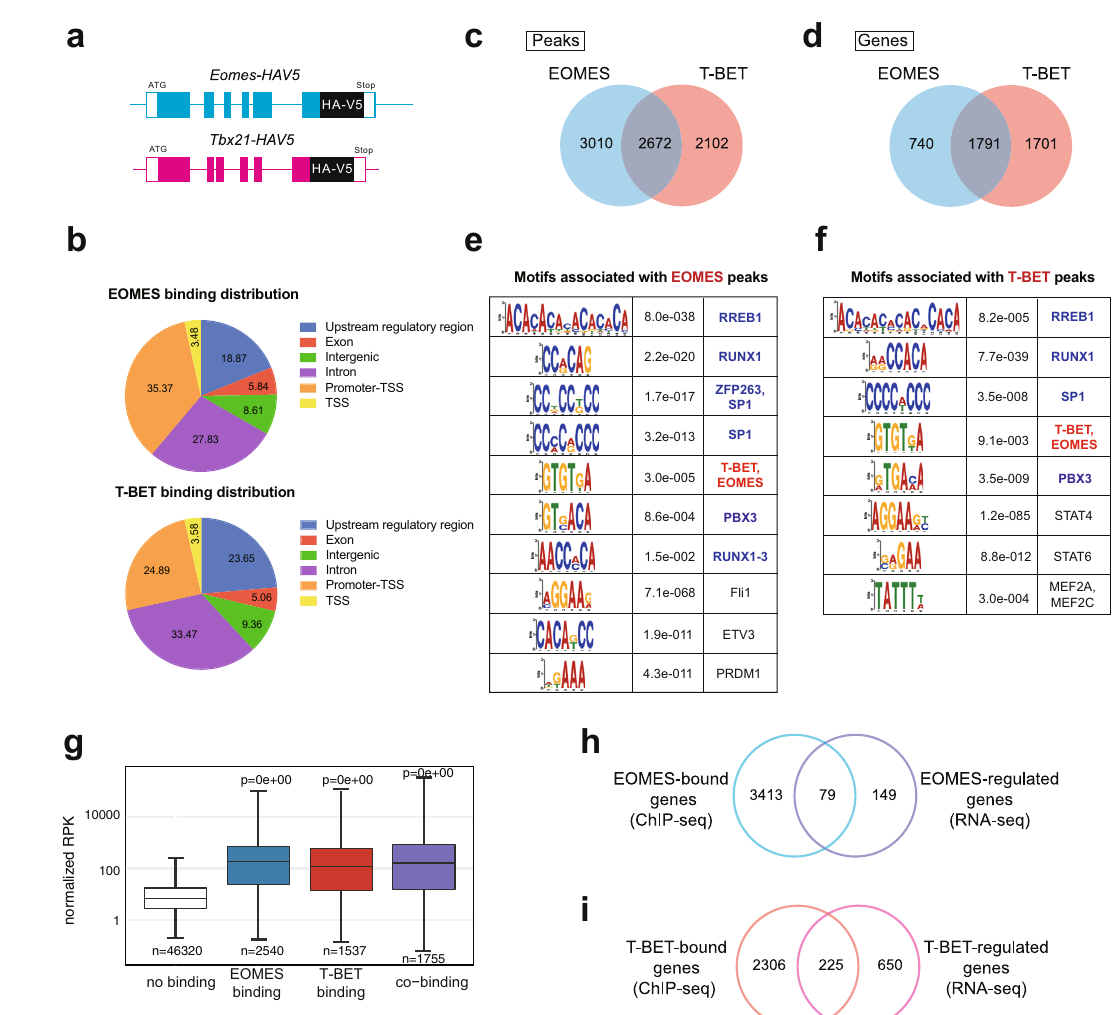
Examples of ChIP-seq tracks for direct EOMES targets are shown in Supplementary Fig. 10B.